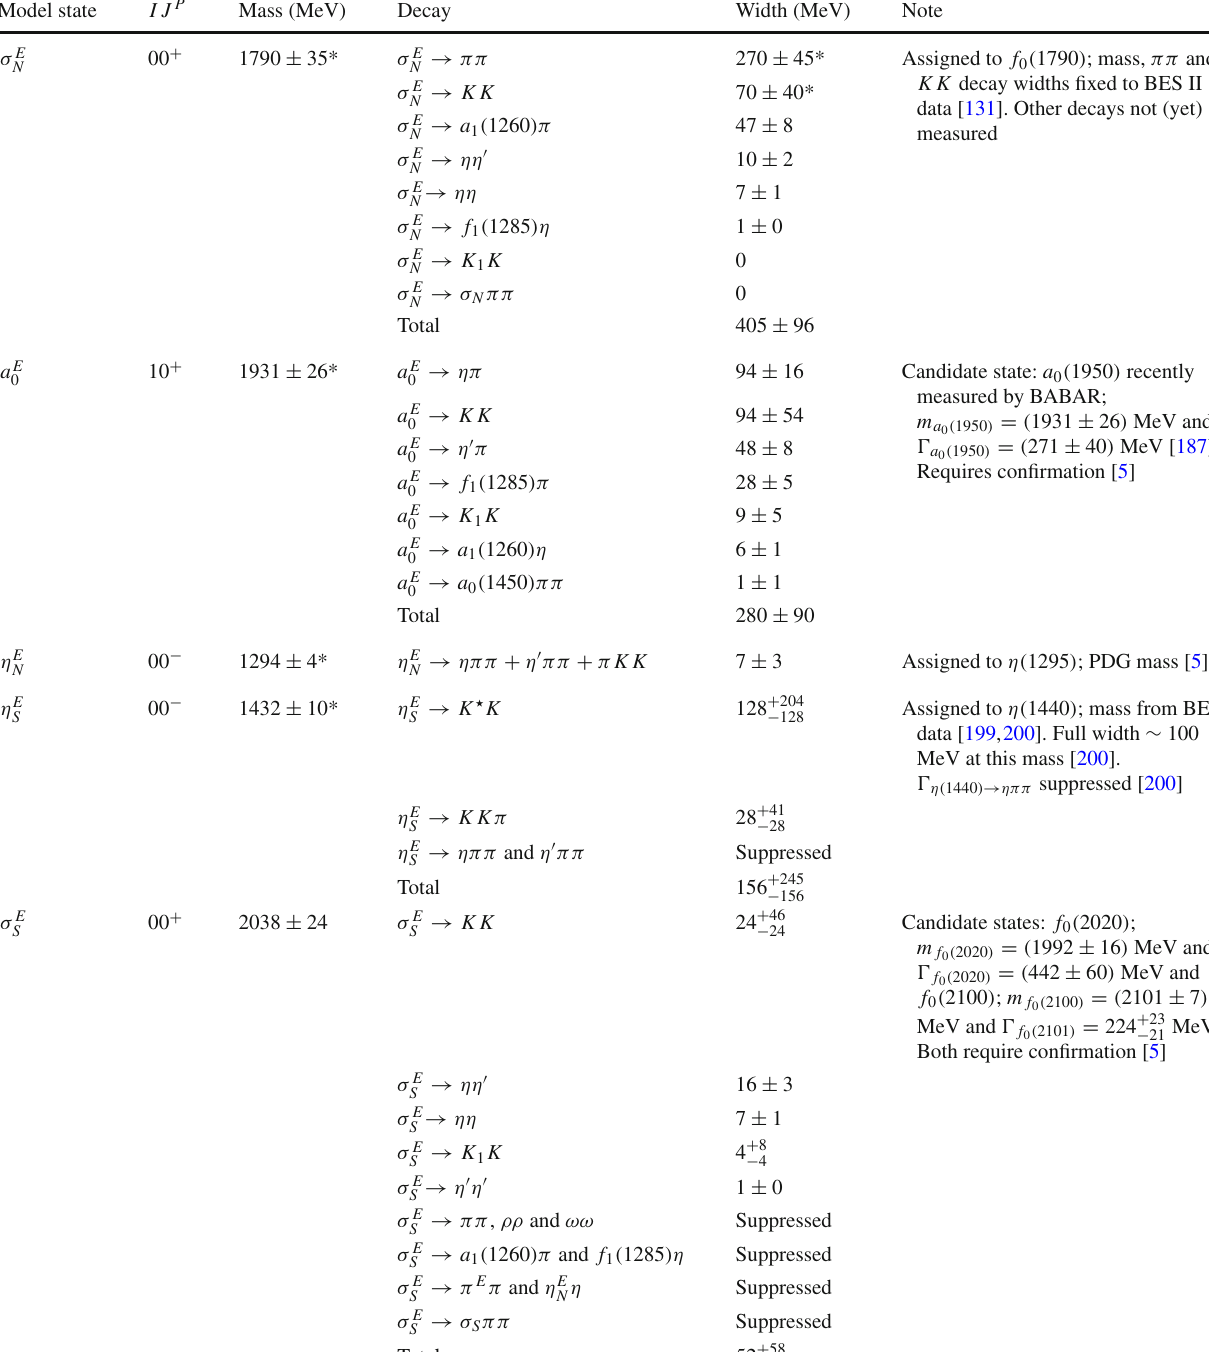
Table 6 Final results: decays and masses of the excited ¯ qq states. Widths marked as “suppressed” depend only on large- N c suppressed parameters that have been set to zero. Masses/widths marked with (*) are used as input; others are predictions Model